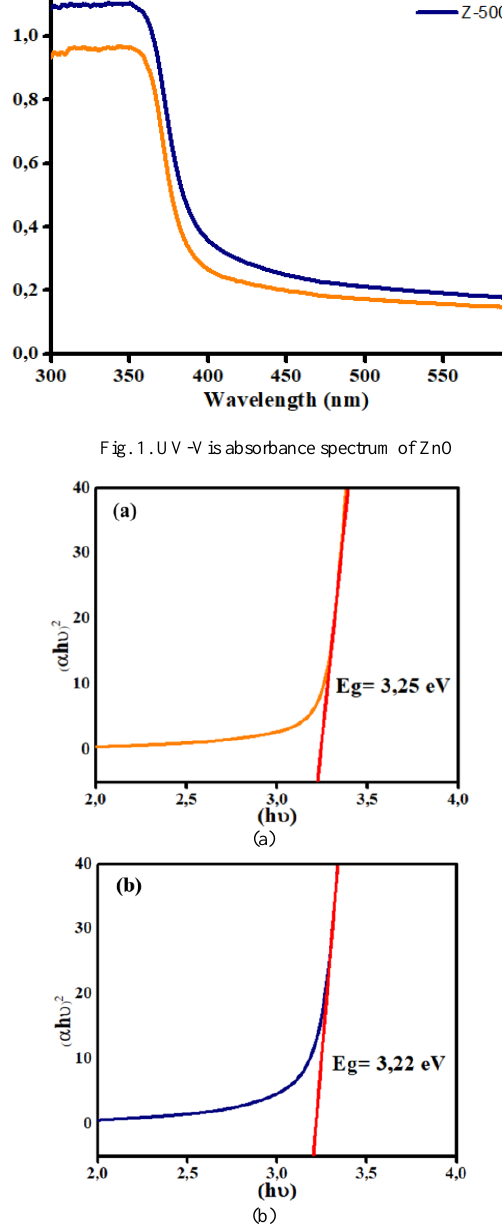
Fig. 2. Bandgap energy (a) (hʋ) vs (αhʋ) 2 Z-200 dan (b)